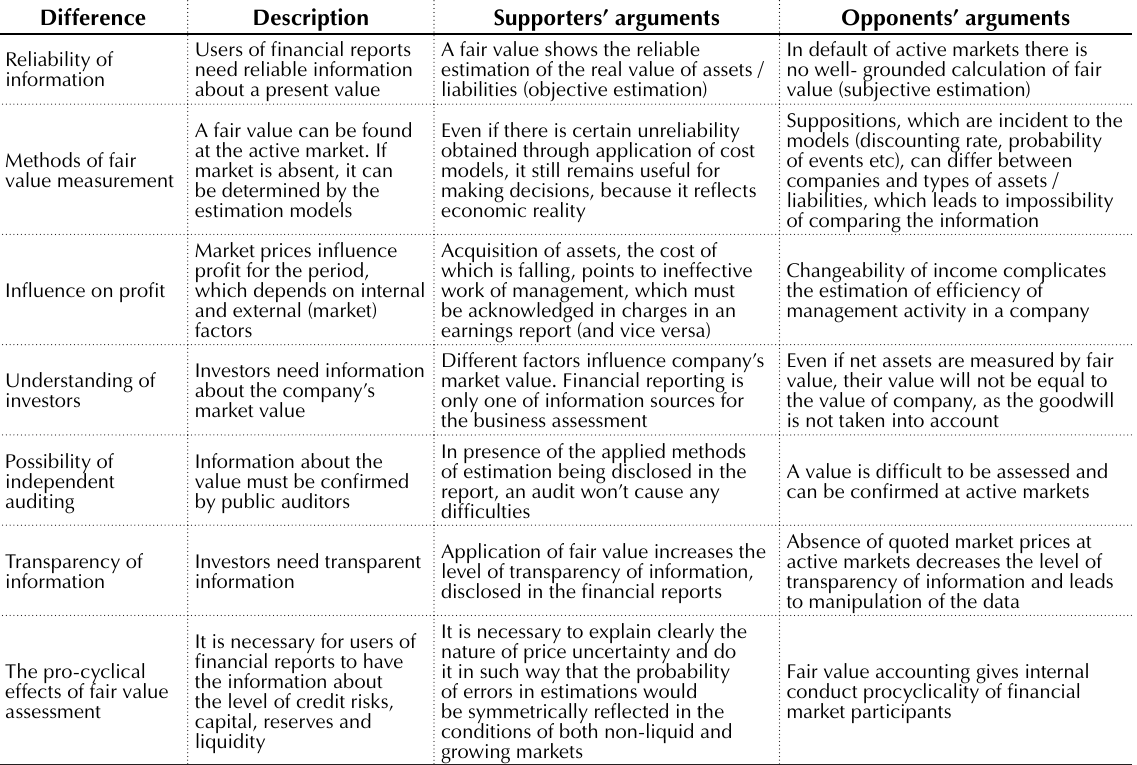
Table 1. Generalization of main differences of fair value assessment between its supporters and opponents